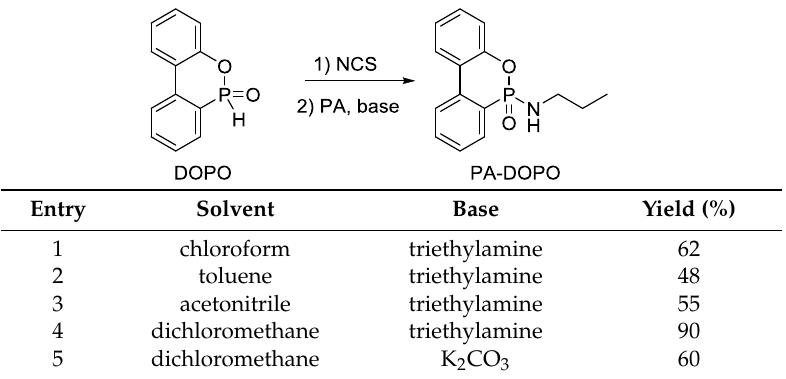
Table 2. The optimization of the chlorination reaction using PA-DOPO as a model derivative.